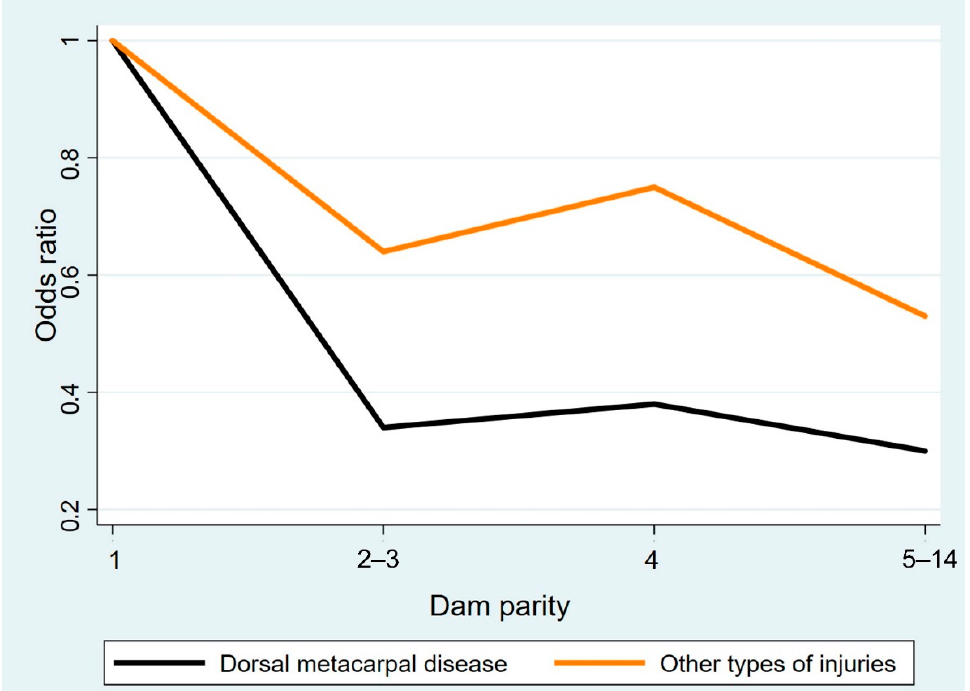
Figure A4. The effect of increasing dam parity on musculoskeletal injury in Thoroughbred racehorses in South-East Queensland, Australia. Results shown are from a univariable conditional logistic regression analysis for 202 cases of musculoskeletal injury and 202 controls matched by trainer and age, analysed by broad categories of injuries.